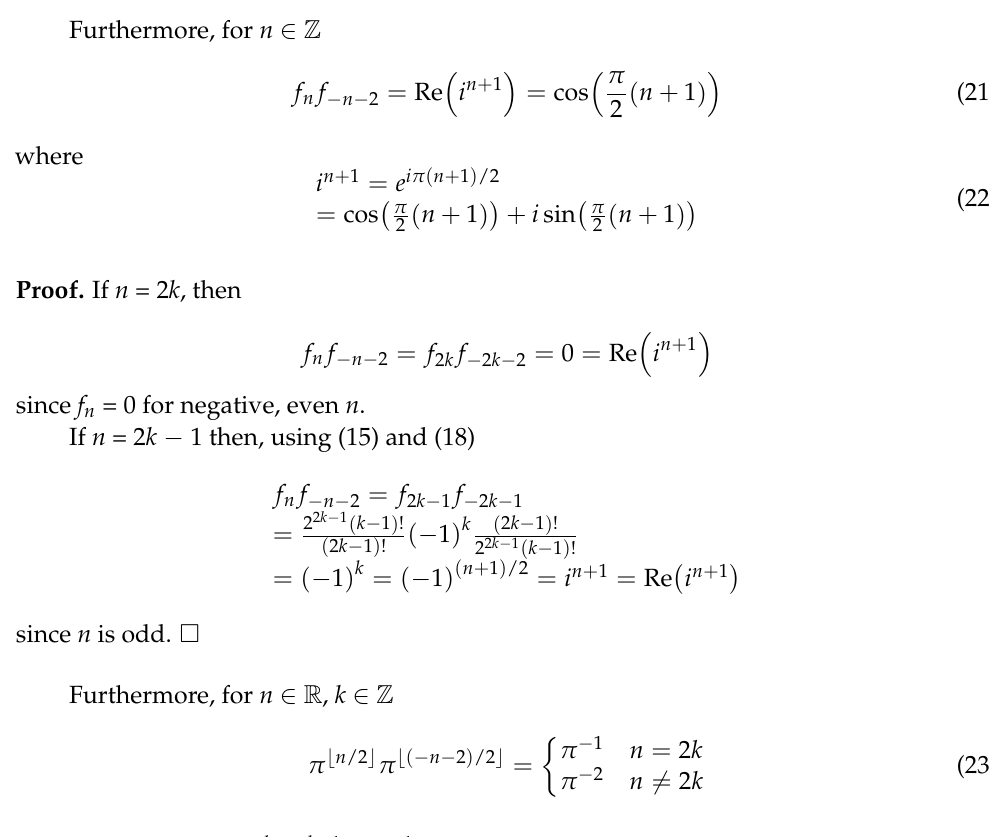
Figure 2. Graphs of volumes ( V ) and surface areas ( S ) of n -balls of unit radius for n = − 25, − 24, … ,15. Table 1. Volumes and surfaces of n -balls for − 11 ≤ n ≤ 9.